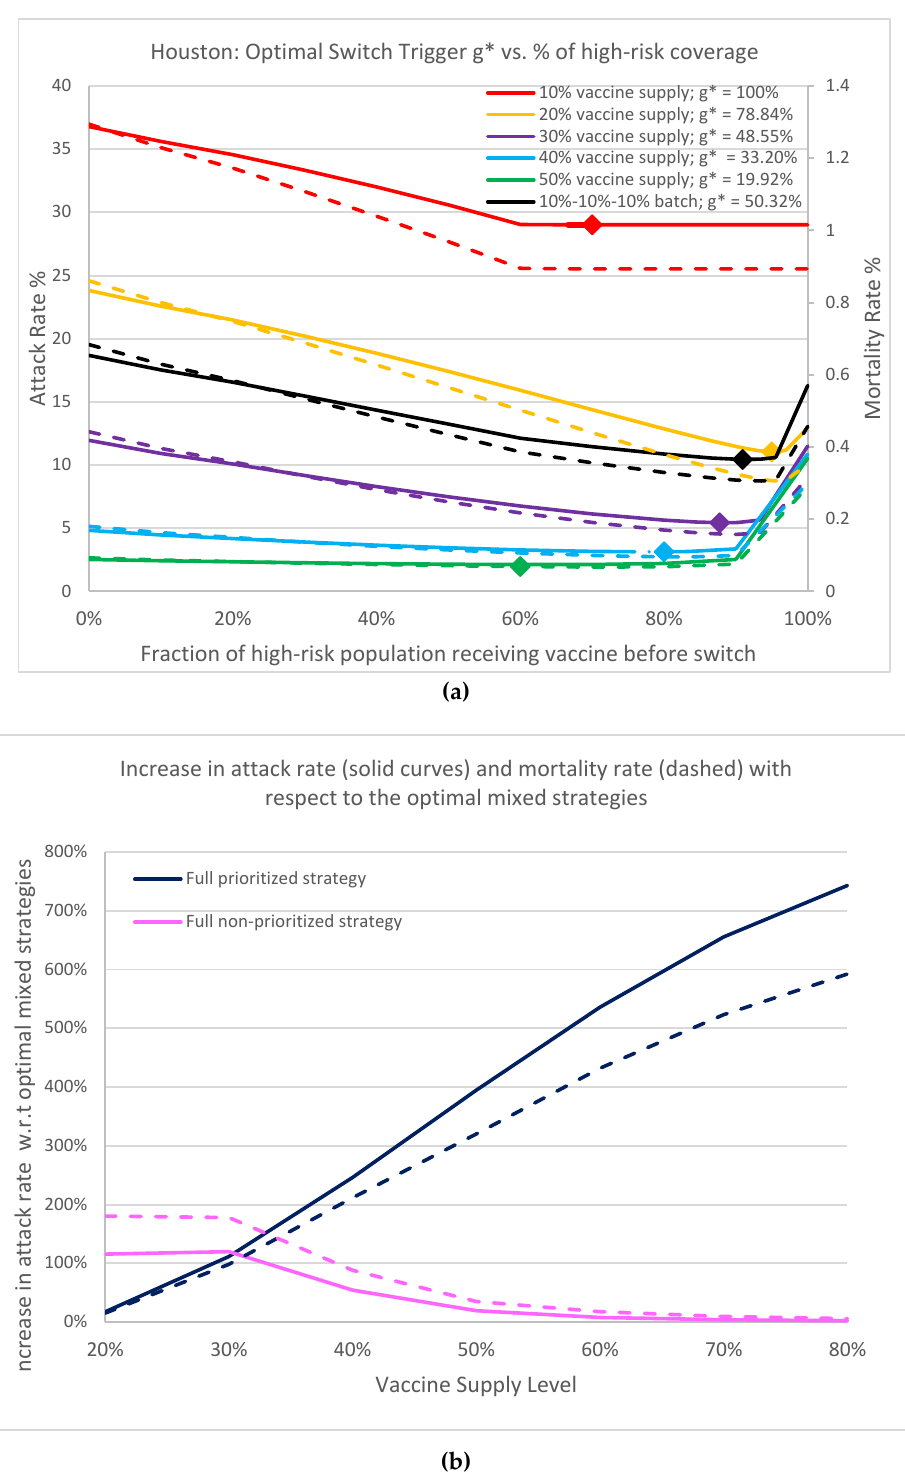
Figure 4. ( a ) Plot of overall attack rate and mortality rate (evaluated on Day 360) as a function of percentage of high-risk coverage. R 0 = 1.2. Red, yellow, purple, blue and green curves correspond to, respectively, 10%, 20%, 30%, 40% and 50% uninterrupted vaccine supply inventory. The black curves show the batched 30% vaccine supply with delay: 10% arrived on Day 0, Day 30, and Day 60. Solid curves denote attack rates, dashed denote mortality rates. Points marked on the curves indicate the associated optimal switch trigger. ( b ) This graph shows the rapid increase in attack rates (solid curves) and mortality rates (dashed curves) for full prioritized strategies with respect to the optimal mixed strategies as more vaccine becomes available. It also shows that there is more urgency to open up more vaccines to the general